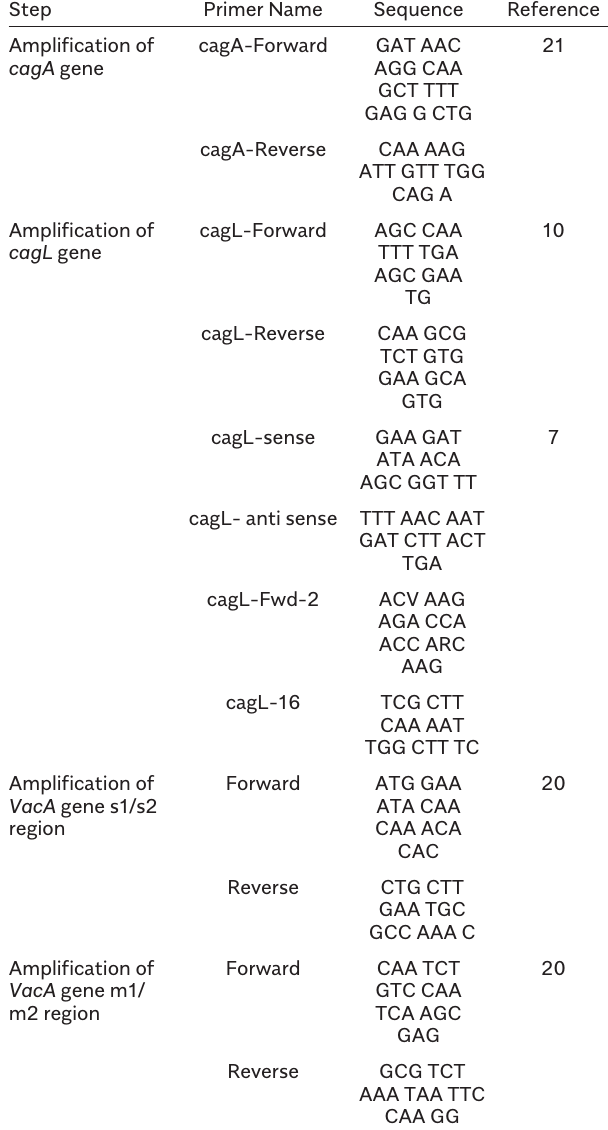
reaction included a positive (DNA from strain 26695) and a negative control. All reactions were performed in a Mastercycler Ep gradient thermocycler (Eppendorf, Hamburg, Germany). Polymerase chain reaction products were analyzed by agarose gel electrophoresis at 1.5% and stained with ethidium bromide. A second PCR was per- formed with DNA from those strains that were negative in the first reaction, using primers cagL Fwd-2 and cagL -16, which amplified a 165-bp product.